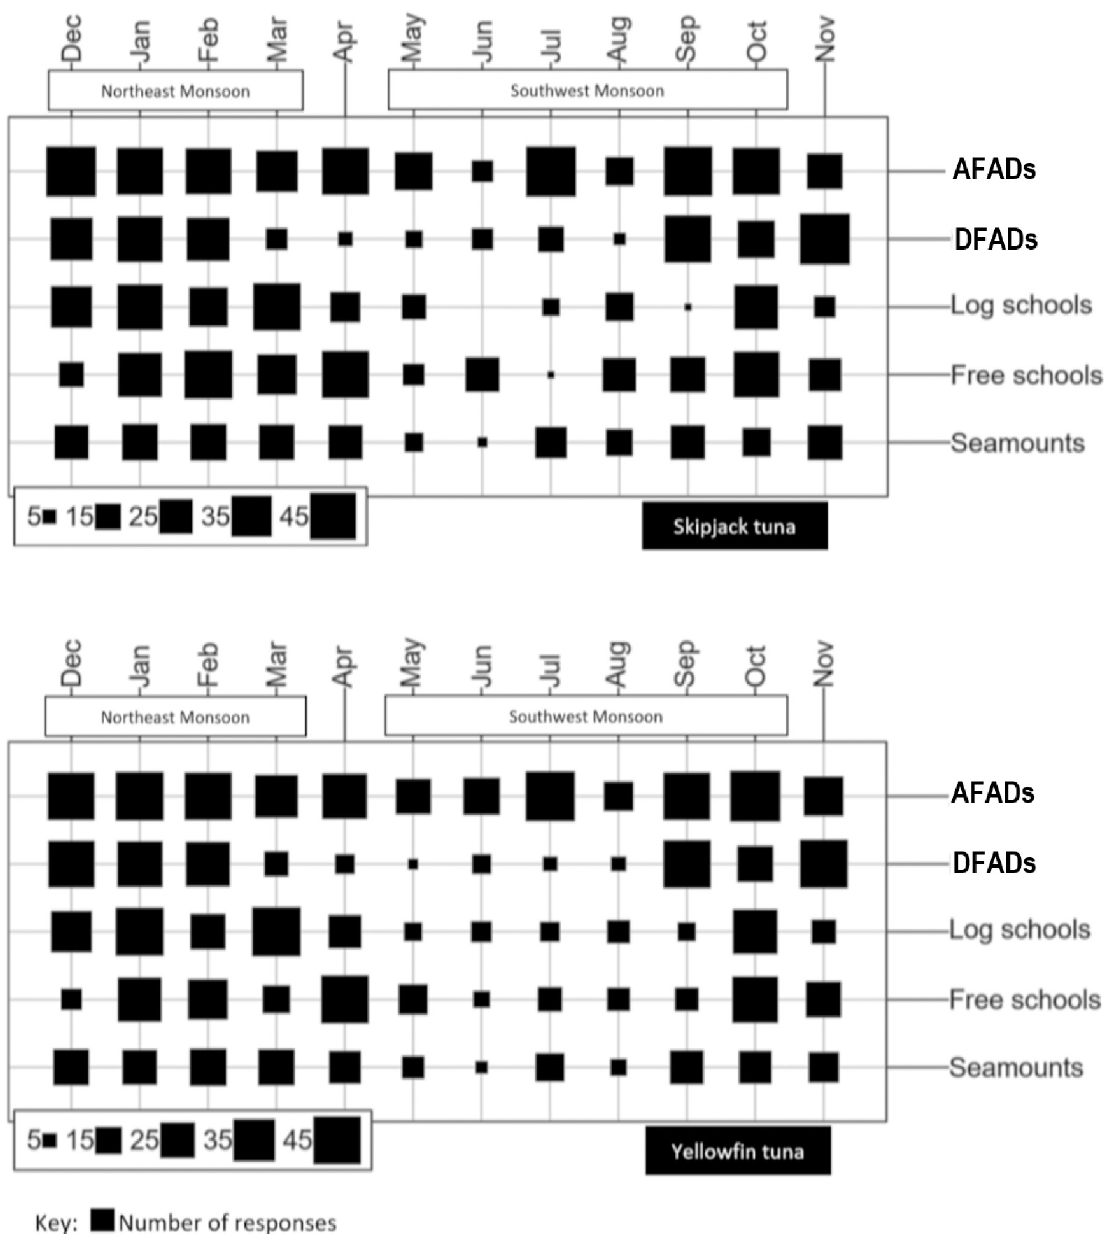
Fig 2. Fishers’ response on the seasonal variation in abundance of two tuna species at five types of schools in the Maldives. April and November are inter-monsoon periods. at AFADs. Only a few fishers (11%) thought that there is a variation in the horizontal distance of tuna from AFADs over the day. Nearly half (40.7%) of the fishers interviewed thought that tuna stayed at the AFADs for 3 to 6 days while nearly one third (29.6%) believed that they stay less than 3 days. Few fishers (9.3%) suggested that aggregations can last for more than 10 days (but they specified that this occurs at very few AFADs during very good fishing periods). Most of the fishers (74%) suggested that tuna could be attracted to AFADs from up to 2 miles. A few